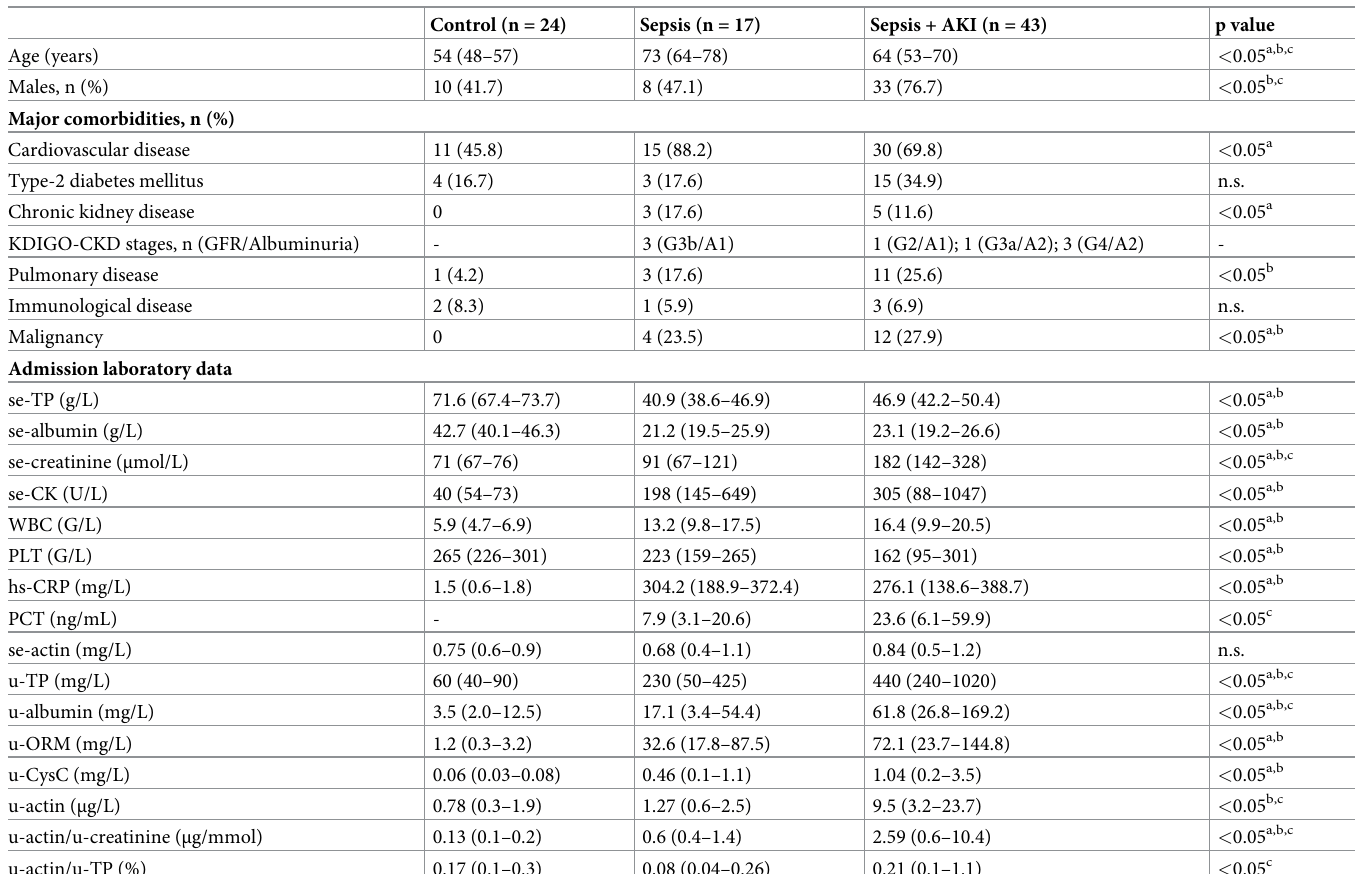
Table 1. Patients’ demographic and admission laboratory